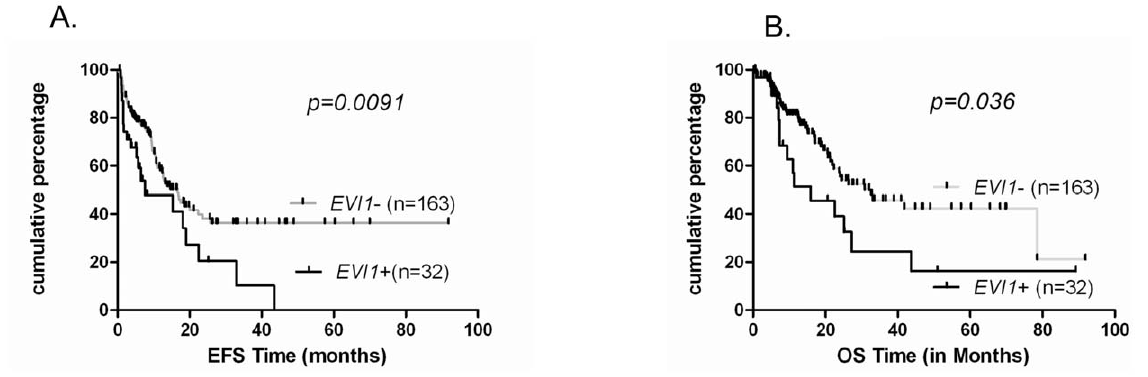
Figure 5. High EVI1 expression associates with poor survival outcome. Kaplan Meier analysis of two groups with expression levels above or below the cut-off as described in method section for EVI1 (delta CT , 7). EFS (A) and OS (B) were assessed in 195 patients.